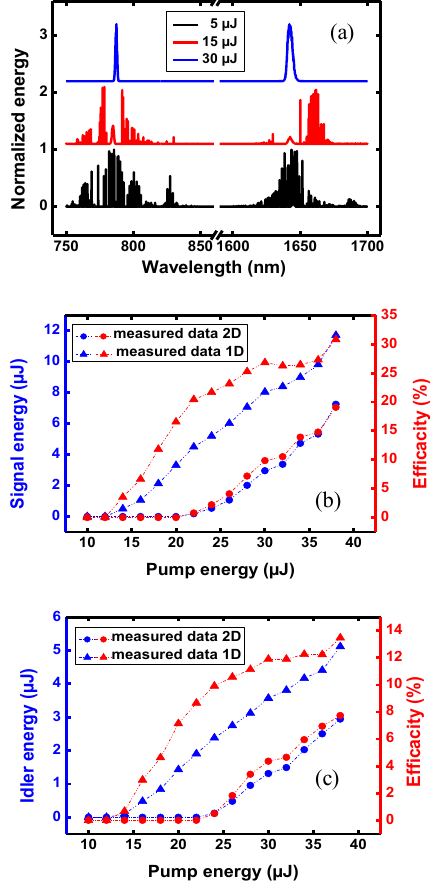
Fig.2. (a) The broad spectrum of signal and idler waves generated from a 1D-PPLT nonlinear photonic crystal before the threshold ( E p =5µJ), near and at three time of the threshold. The conversion efficiency of 1D and 2D-PPLT at 110°C (b) Signal (787nm), (c) Idler